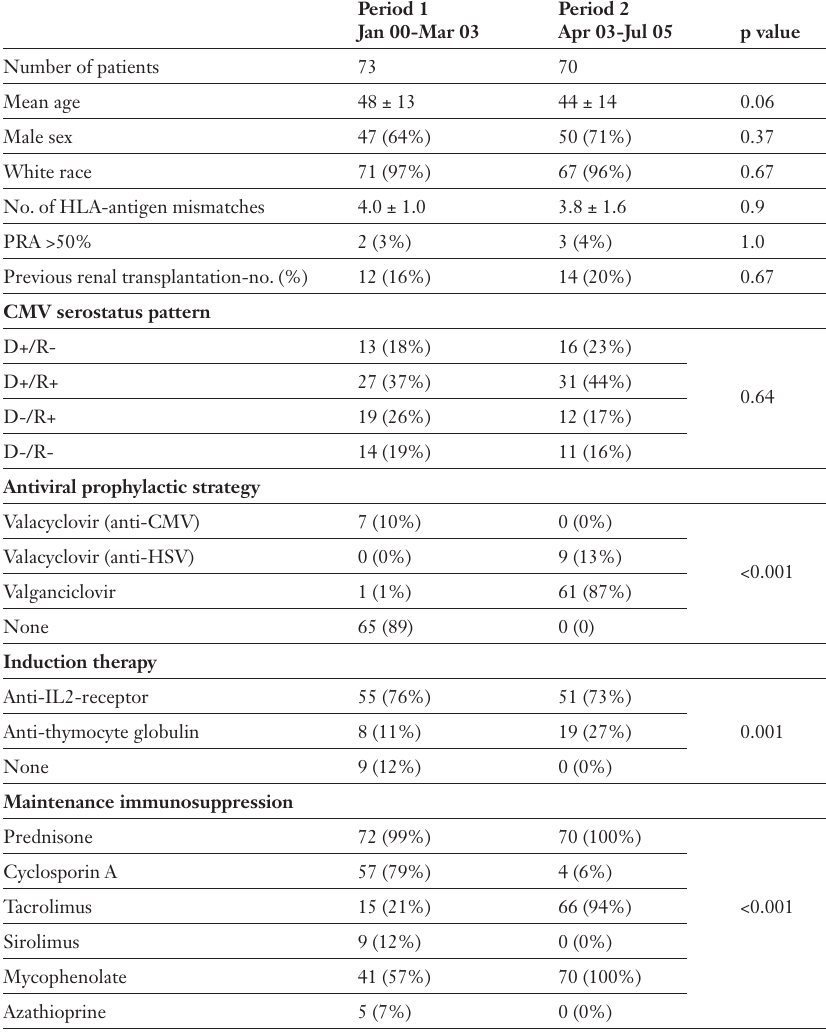
Clinical characteris- tics of